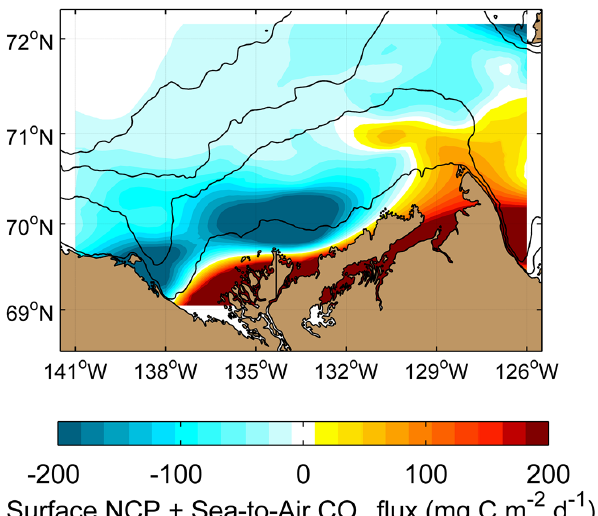
Figure 12. Map of the sum of surface net community production (NCP) and sea-to-air CO 2 fluxes for the ArcticNet–Malina cam- paign of mid-summer 2009. This map aims at showing the spa- tial discrepancy between CO 2 fluxes and ecosystem metabolism. A positive value (reddish) means that the potential for CO 2 sink due to positive NCP is dampened by external forcings (e.g., upwelling of CO 2 -rich waters, warming, photomineralization). While nega- tive values (turquoise) mean that the potential for CO 2 source due to negative NCP is compensated by other factors (e.g., past produc- tivity and vertical export, dilution, cooling). Bathymetric contours are 20, 100, 1000, and